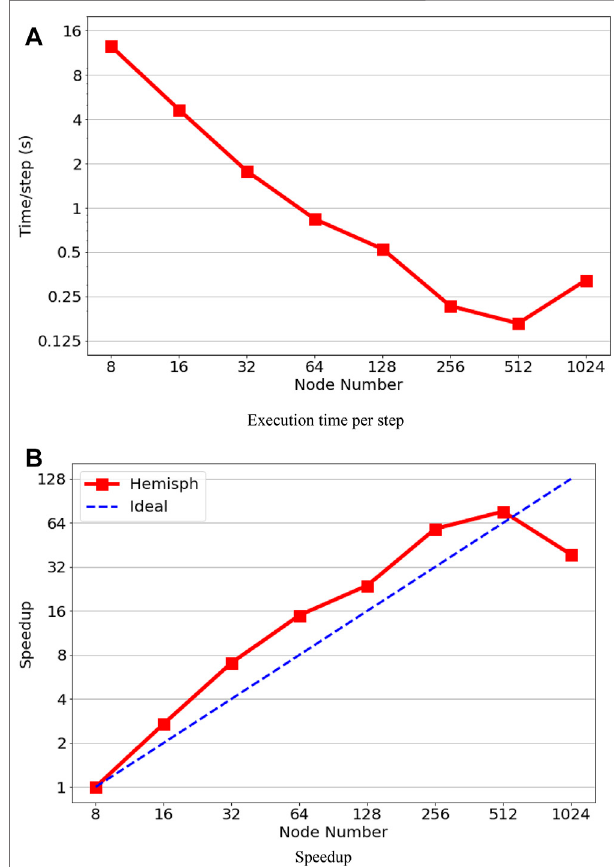
FIGURE 8 | Performance results on the Hawk system. (A) Execution time per step. (B)